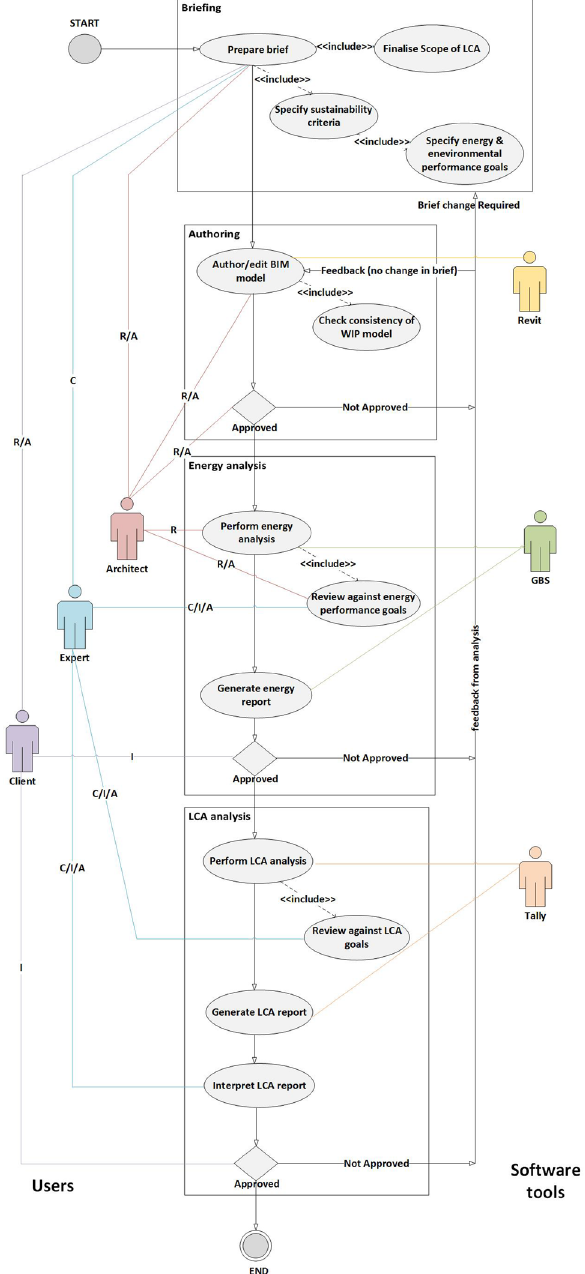
Fig. 9 Use case scenario of BIM-LCA enabled sustainability assess-